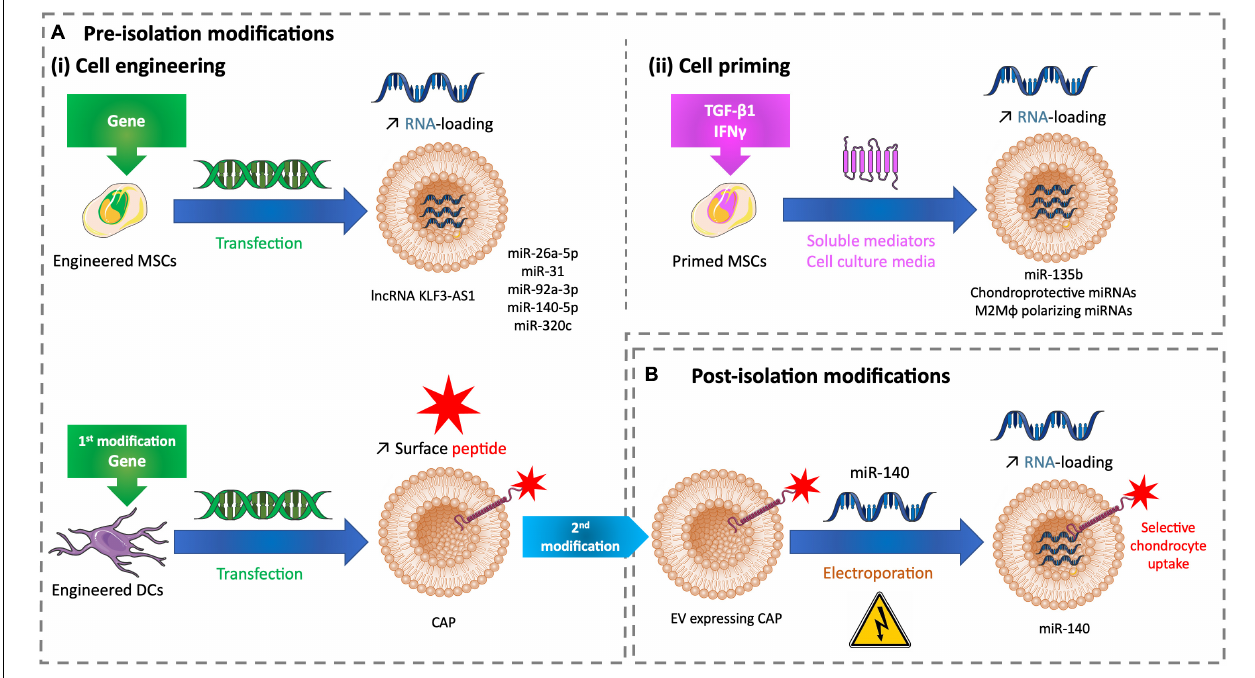
FIGURE 2 | Tuning methods to improve the drug loading of therapeutic EVs for cartilage healing. (A) Methods of modifications used before EV isolation to tune EVs with (i) cell engineering by transfecting cells or (ii) cell priming by treating cells with soluble mediators added to cell culture medium. (B) Methods of modifications used after EV isolation to tune EVs with miRNA electroporation. DC, dendritic cell; EV, extracellular vesicle; CAP, chondrocyte affinity peptide; IFN- γ , interferon γ ; lncRNA, long non-coding RNA; M2M ϕ , M2 macrophage; miR, microRNA; miRNA, microRNA; MSC, mesenchymal stem cell; TGF- β 1, transforming growth factor β